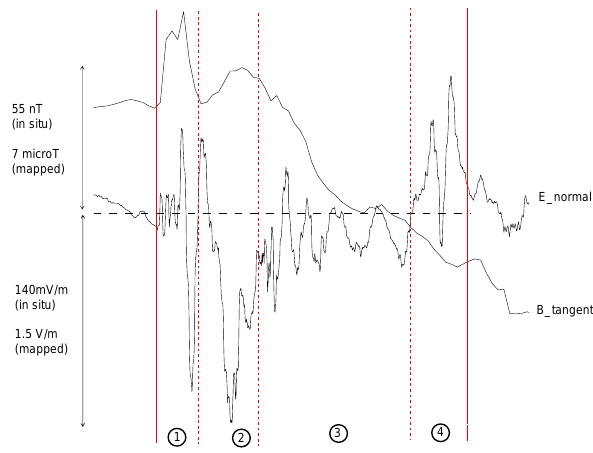
Fig. 3. Zoom plot of the electric field normal component and of the magnetic field tangent component for the time interval 17:47– 17:52UT. The four regions in analysis are delimited by the red ver- tical